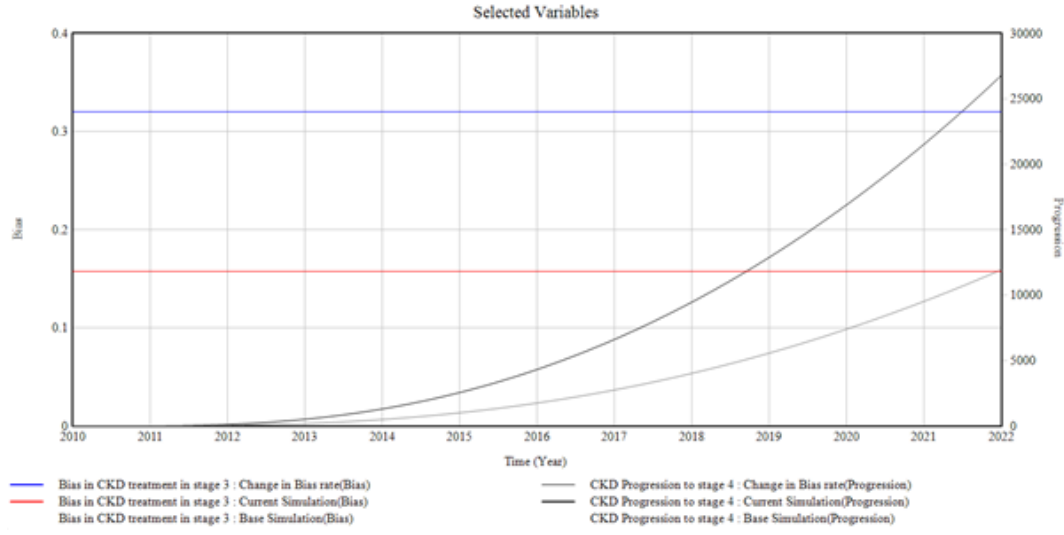
Figure 5. The Bias Rate in Stage 3 CKD vs. CKD Progression to Stage 4 CKD.